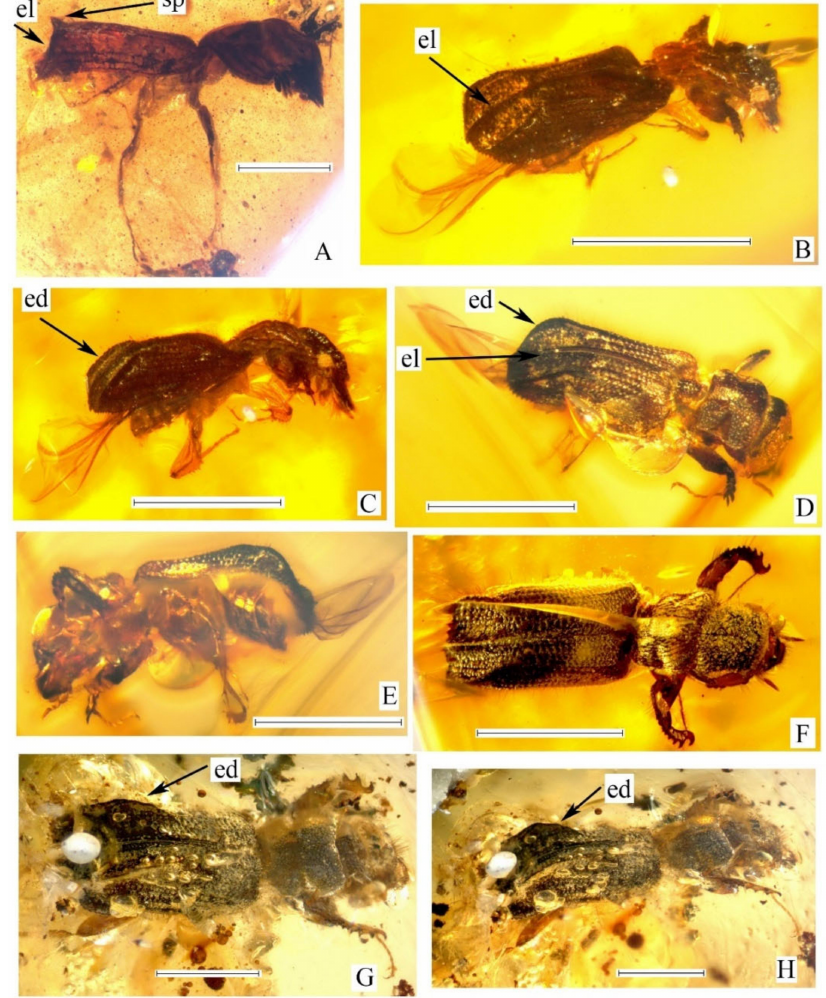
Figure 2. Poinarinius spp. in Myanmar amber: ( A ) P . perkovskyi sp. nov., holotype, male, ISEA MA2020/4, lateral view; ( B ) P . aladelicatus , female, ISEA MA 2018/24, dorso-lateral view; ( C ) P . aladelicatus , female, ISEA MA2018/24, lateral view; ( D ) P . aladelicatus , male, ISEA MA2018/30, dorso- lateral view; ( E ) P . aladelicatus , male, ISEA MA2018/30, ventral view; ( F ) P . aladelicatus , male, ISEA MA2019/26, dorsal view; ( G ) P . zahradniki sp. nov., holotype, female, ISEA MA2018/27, dorsal